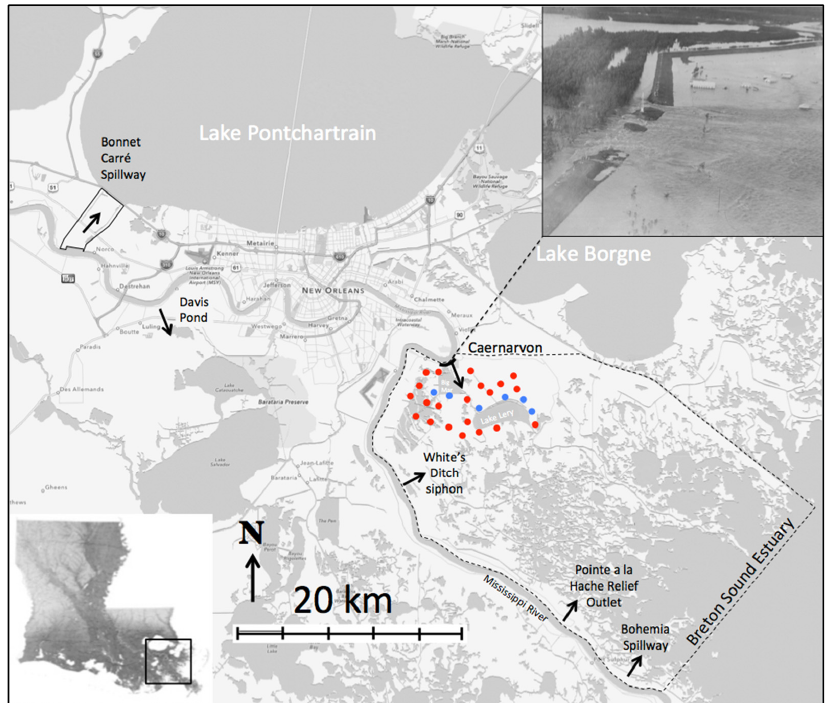
Figure 2. The Breton Sound estuary. Dots indicate where core samples were taken and the approximate area of the crevasse splay deposit based on our measurements. Blue dots indicate cores that had additional analysis carried out. Upper right inset: aerial photo showing Mississippi River water flowing through the 1927 Caernarvon levee breach. Dark black line at the site of the crevasse is the estimated width of the levee breach.